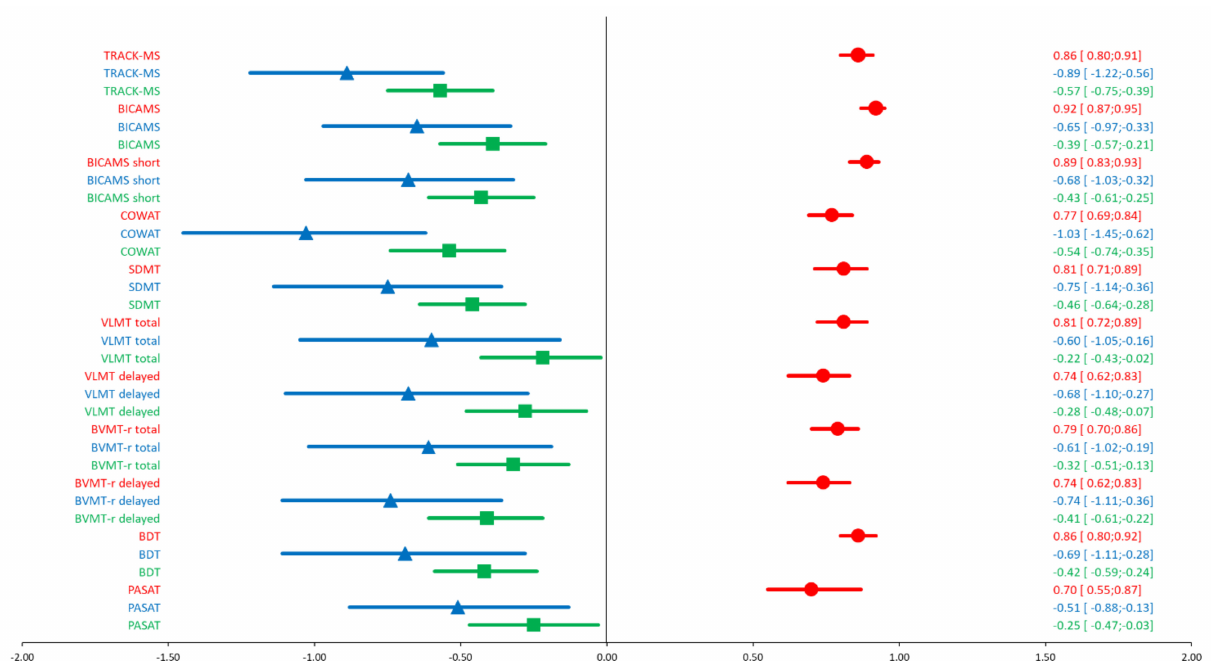
Figure 1. Reliability and validity: Association of baseline cognitive test scores to its re-test scores (test-retest reliability) and to MS-related disability (EDSS, validity). Group difference in baseline cognitive test scores between MS patients and healthy controls (validity). (cid:4) Comparison MS